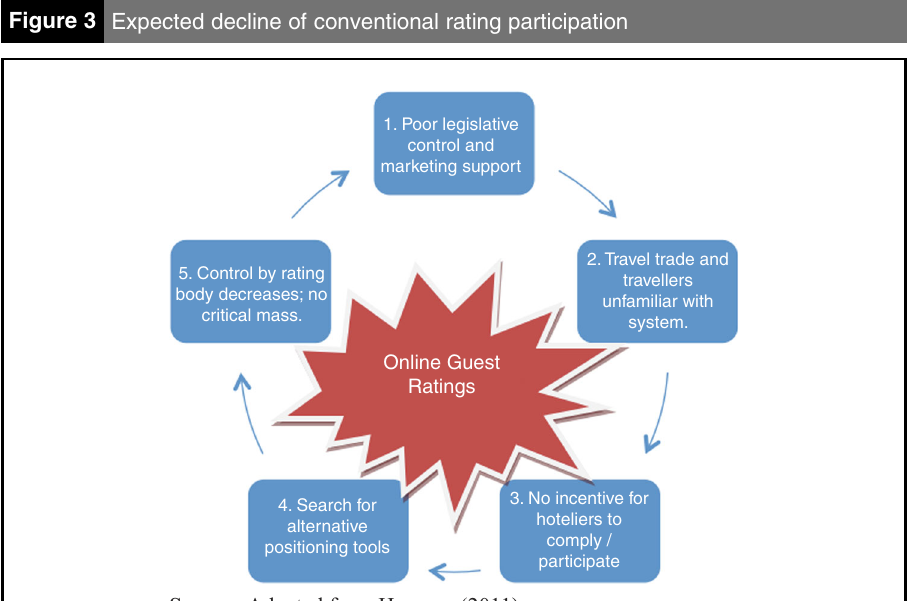
Figure 3 Expected decline of conventional rating